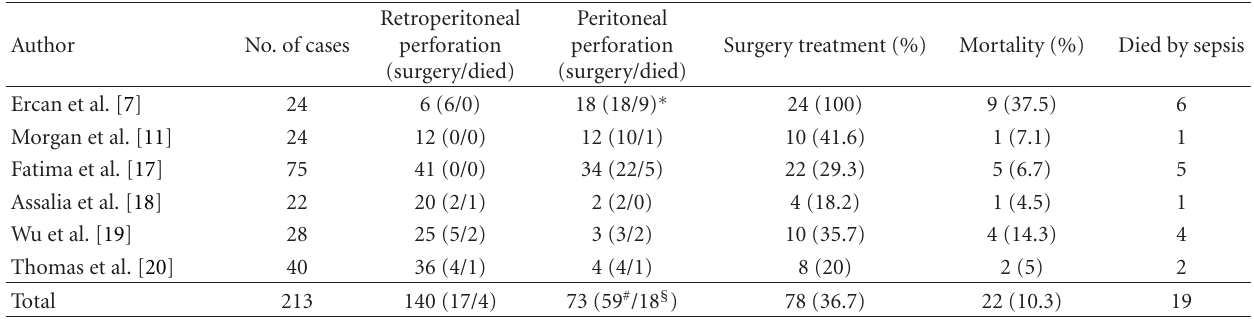
Table 2: The perforations management and mortality in recent literature.